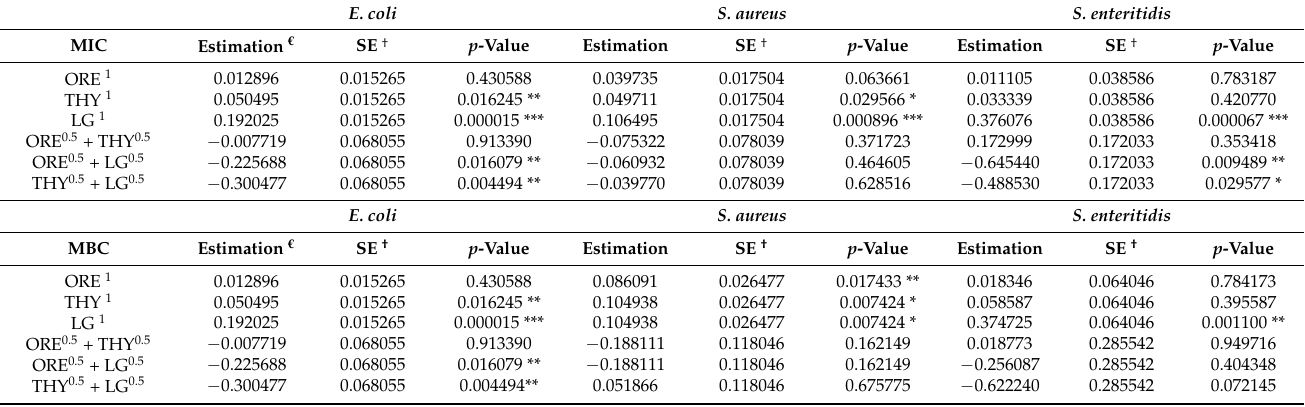
Table 2. Coefficients of model fitted for minimum inhibitory concentration (MIC) and minimum bactericidal concentration (MBC) values concerning essential oils (EOs) against Escherichia coli , Staphy- lococcus aureus , and Salmonella enterica serotype Enteritidis and their level of significance. E.